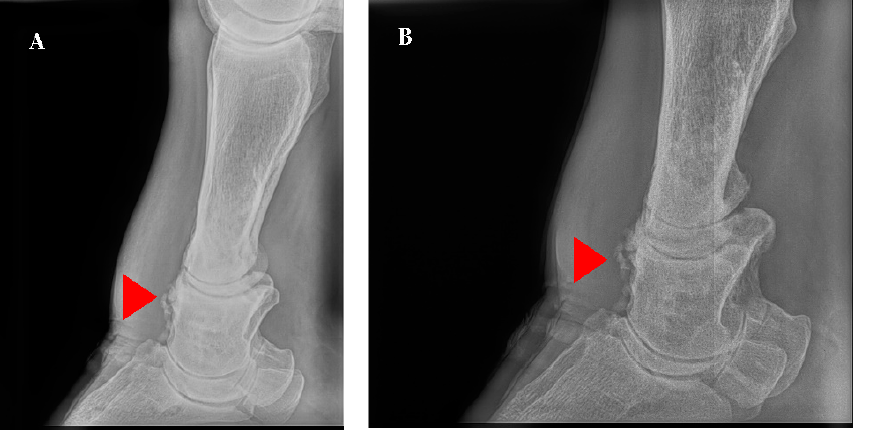
Figure 5 . Radiographs (DLPMO view) taken for a 22-year-old female reticulated giraffe ( Giraffa ca- melopardalis reticulata ) left forelimb in the United Arab Emirates. ( A , B ) shows abnormal growth of osteophytes at the border of the shorter pastern bone. All articulations of the joints are in good con-